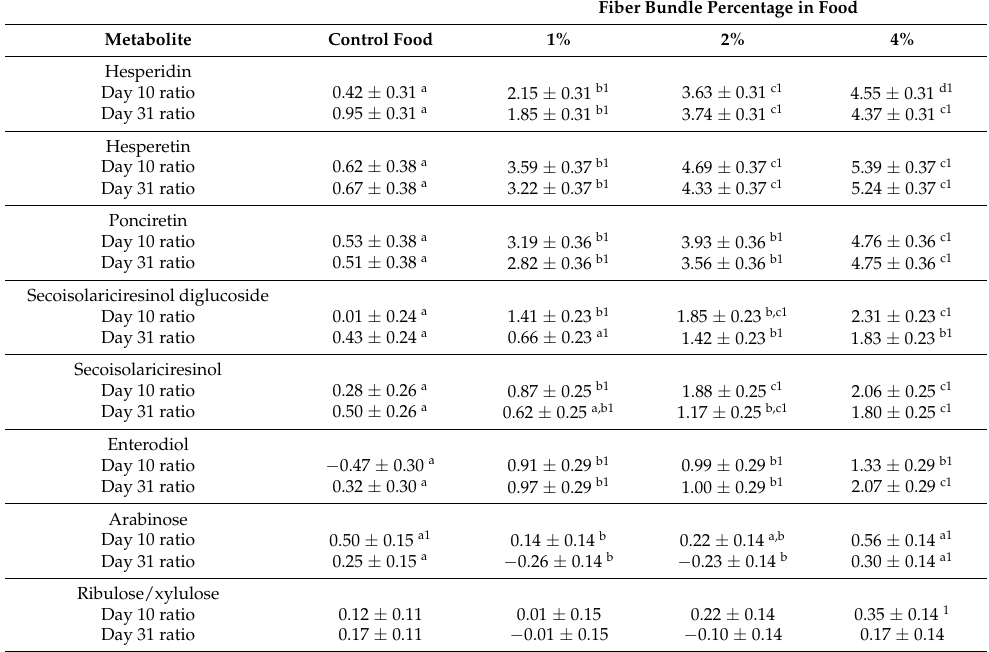
Table 5. Change from initial concentrations at Days 10 and 31 (natural log day 10 or 31—natural log Day 0) of selected fecal metabolites in dogs that consumed foods containing 0%, 1%, 2%, or 4% of added fiber-bound polyphenol ingredients.